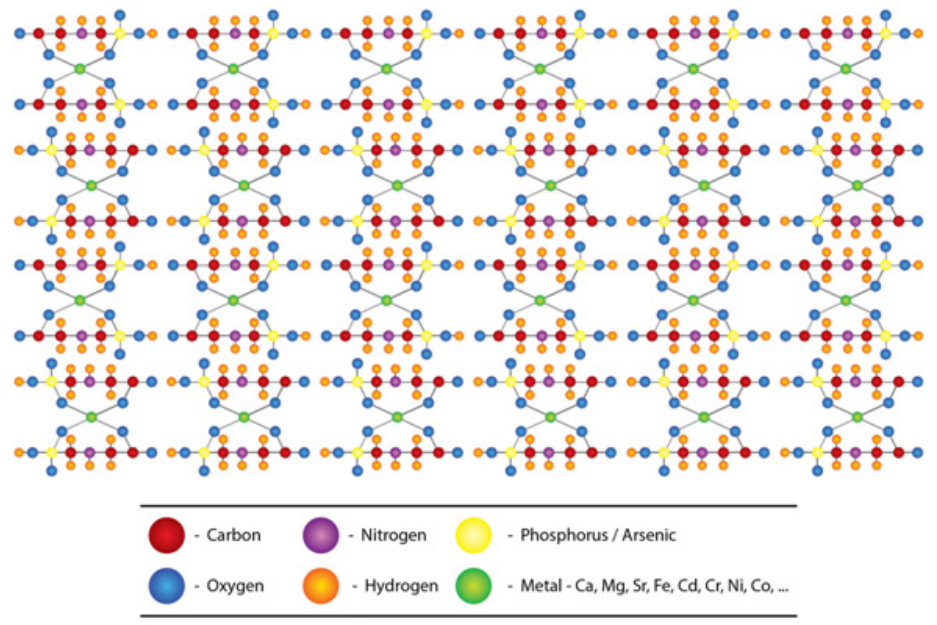
Figure 5. Structure of glyphosate-metal-arsenic